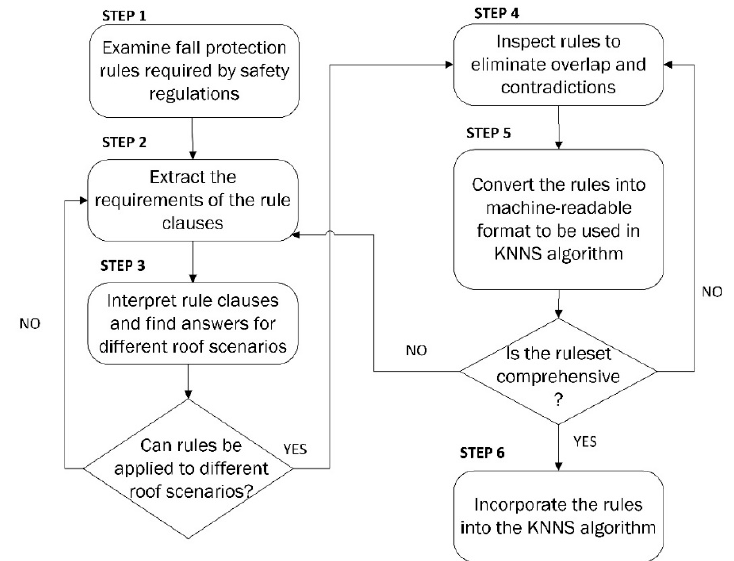
Figure 1. A rule-set algorithm for personal fall arrest system (PFAS) anchor positioning. Table 2. Examples of standard clauses from Occupational Safety and Health Administration (OSHA) [12] and interpreta- tion